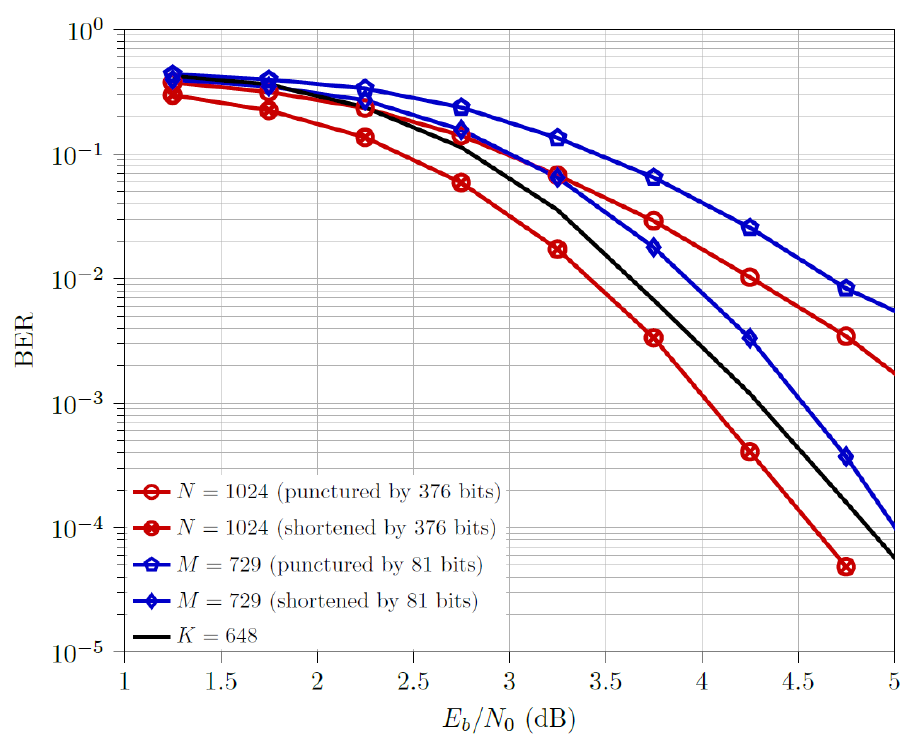
Figure 5. BER performance of Scenario 1 for R d =